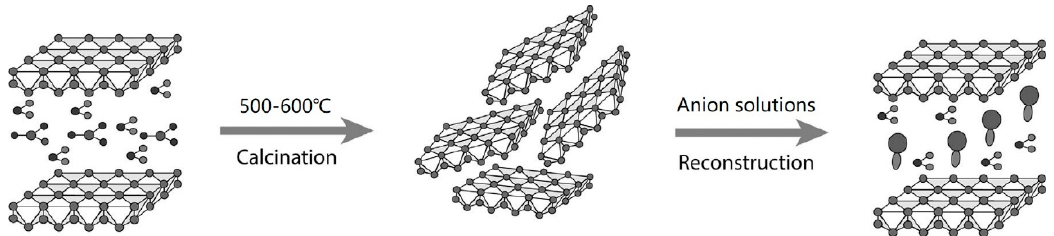
Figure 1. Schematic diagram of LDH structure reconstruction [34].